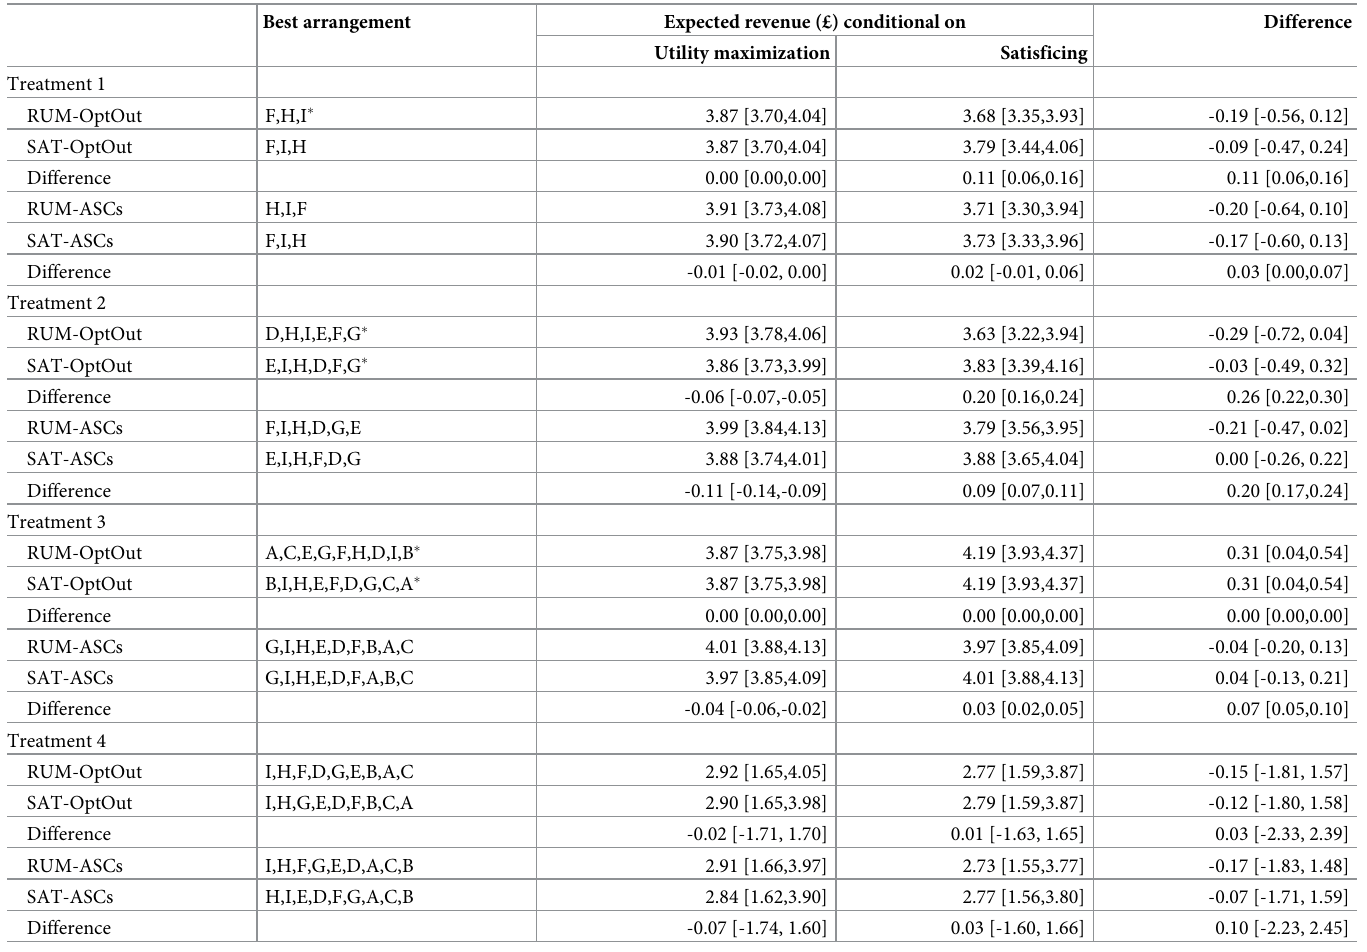
Table 9. Predictions or expected revenue and optimal arrangement for bottles A–I (superior